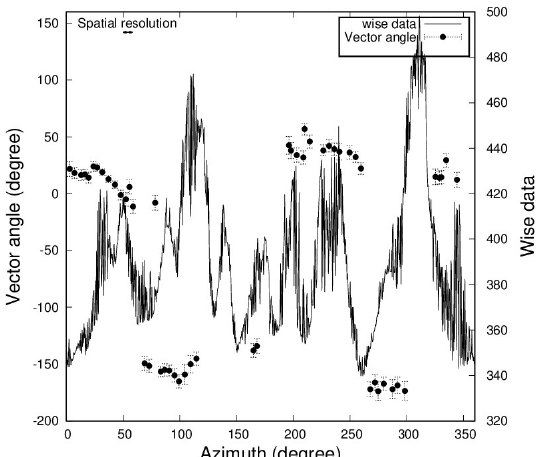
Figure 8. Same as the right panel of Figure 6, but for radius range of 3.40–4.76